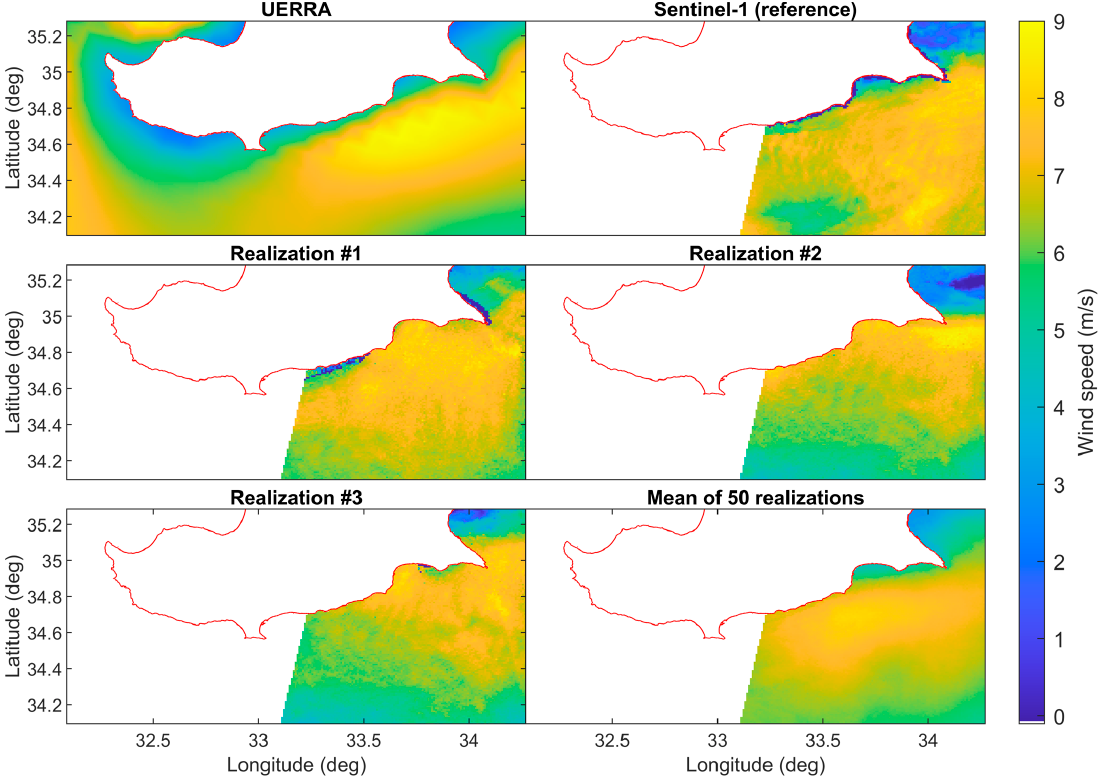
Figure 5. Visual comparison between wind speed (m/s) images from UERRA, Sentinel-1, 3 realiza- tions and the mean of 50 realizations on 10 June 2017.